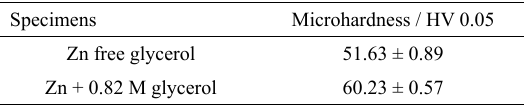
Table 5. Microhardness values of Zn coatings